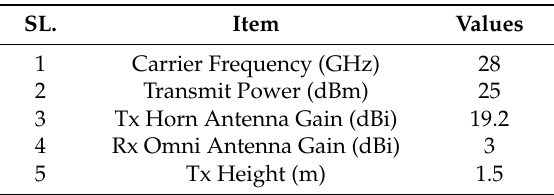
Table 2. Measurement